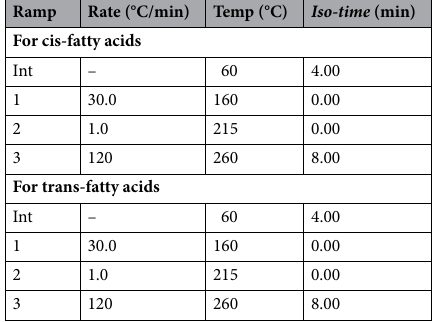
Table 1. GC-program for analysis of fatty